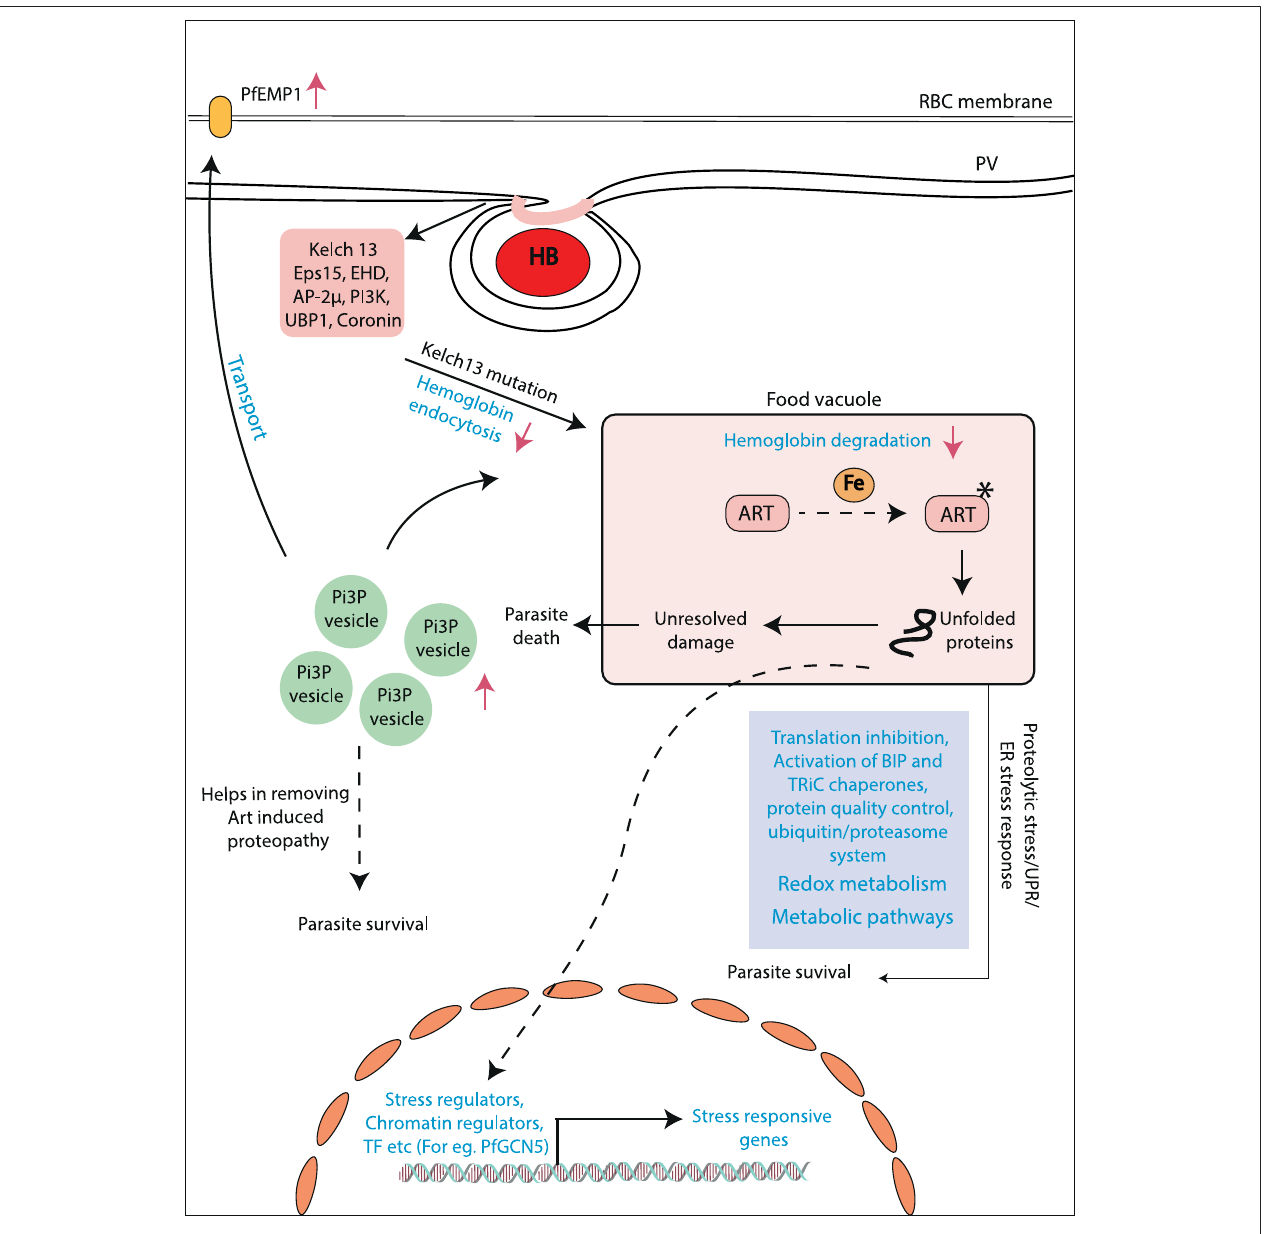
FIGURE 1 | Mechanisms proposed for artemisinin resistance in P. falciparum . Model showing the different mechanism proposed for artemisinin resistance generation. Artemisinin treatment results alkylation of several proteins resulting in the state of stress within the parasites. Different pathways like unfolded protein response and ubiquitin/proteasome system. Stress-like state results in the upregulation of stress induced genes by transcriptional regulators (e.g., PfGCN5). Another mechanism addressesthe roleofupregulated PI3P levels in the artemisinin-resistant parasites. Increased level of thislipid results in increased PI3P vesicles, which houses various proteins helps in the removing artemisinin induced proteopathy. Recent studies have identi fi ed decreased hemoglobin uptake and degradation. This ultimately results in decreased artemisinin activation and, hence, decreased artemisinin sensitivity.